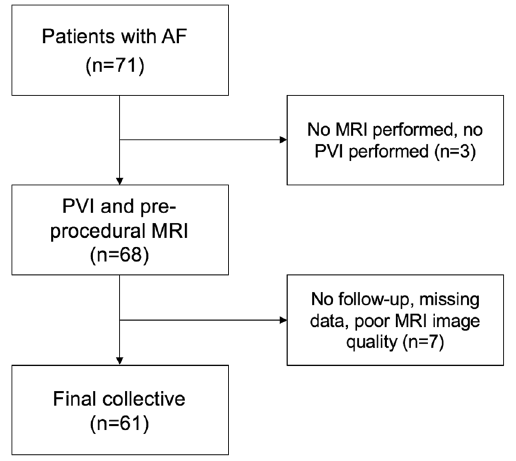
Figure 1. Study flow chart showing number of patients included in this study. The final collective consisted of 61